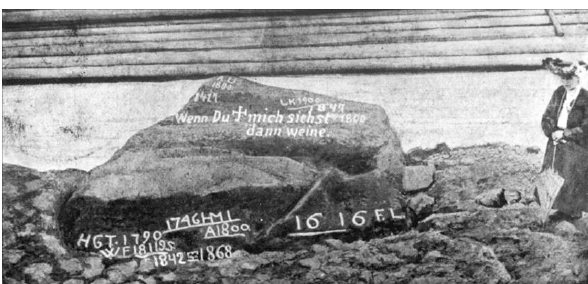
Figure 1. Hydrological drought of 1842 as indicated by a mark on a “hunger stone” on the river Elbe in Dˇeˇcín–Podmokly (Bohemia). This stone appeared during a severe drought in 1904, when the pic- ture was taken (O. Kotyza